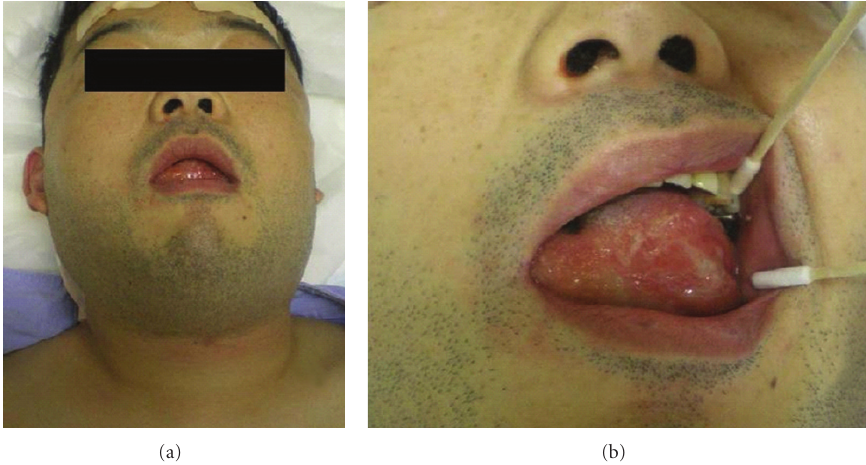
Figure 2: (a) Photograph showing neck and face swelling 13 hours after the operation. (b) Photograph showing tongue swelling on the left side 13 hours after